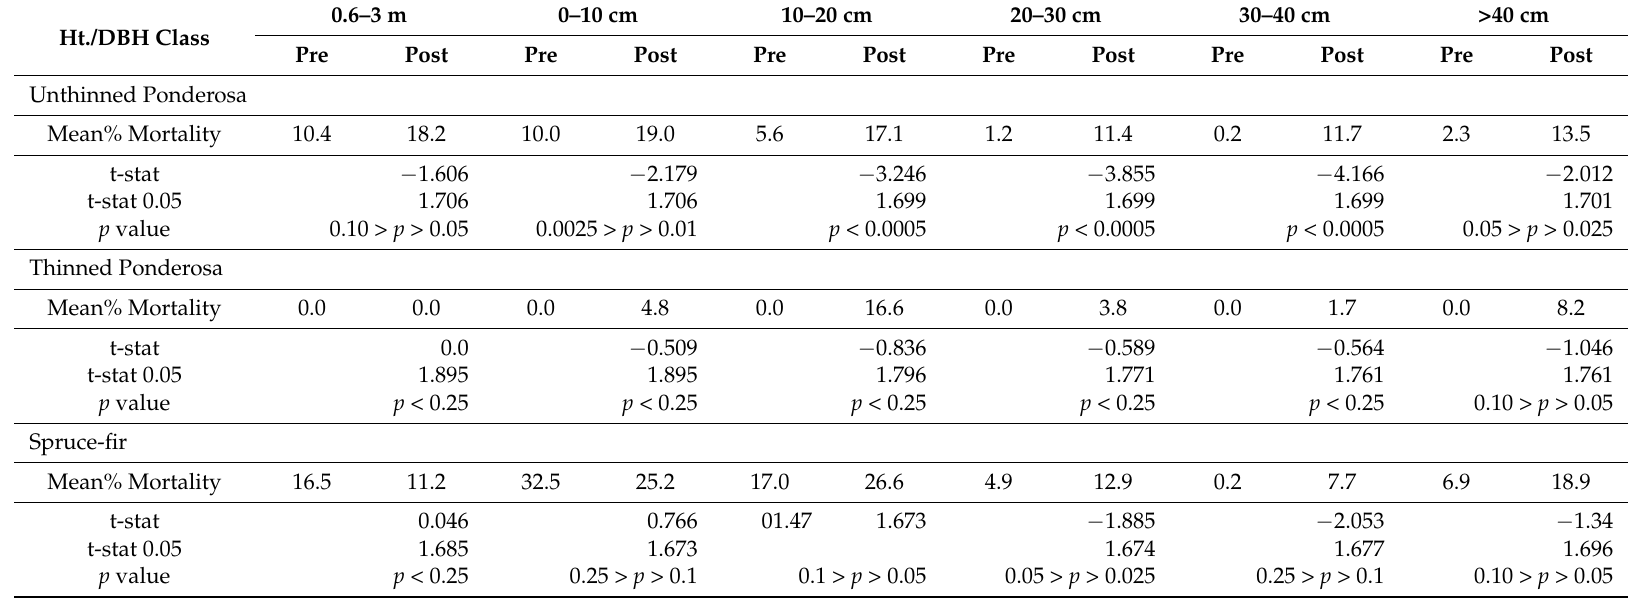
Table 1. Results for two-sample one-tailed t test run on unthinned ponderosa pine, thinned ponderosa pine, and Spruce-fir.